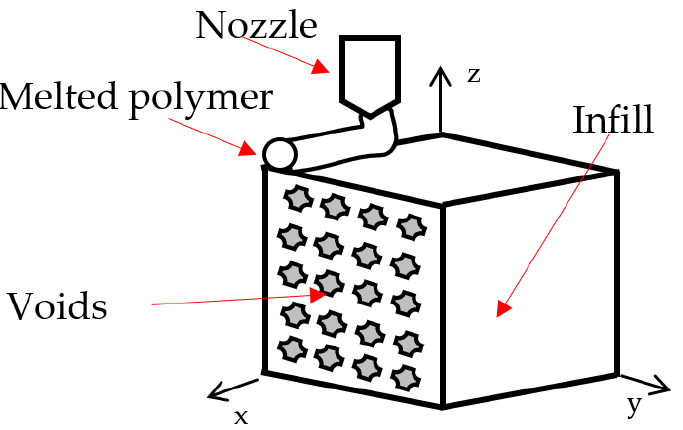
Figure 6. Representation of porosity level for the layers printed by FFF. The elastic modulus in the longitudinal direction ( E 1 ) and in the transversal directions ( E 2 , E 3 ) are given by Equation (10), which is modified by the porosity level p 1 . According to Papon and Haque [40] p 1 is estimated at 10%.